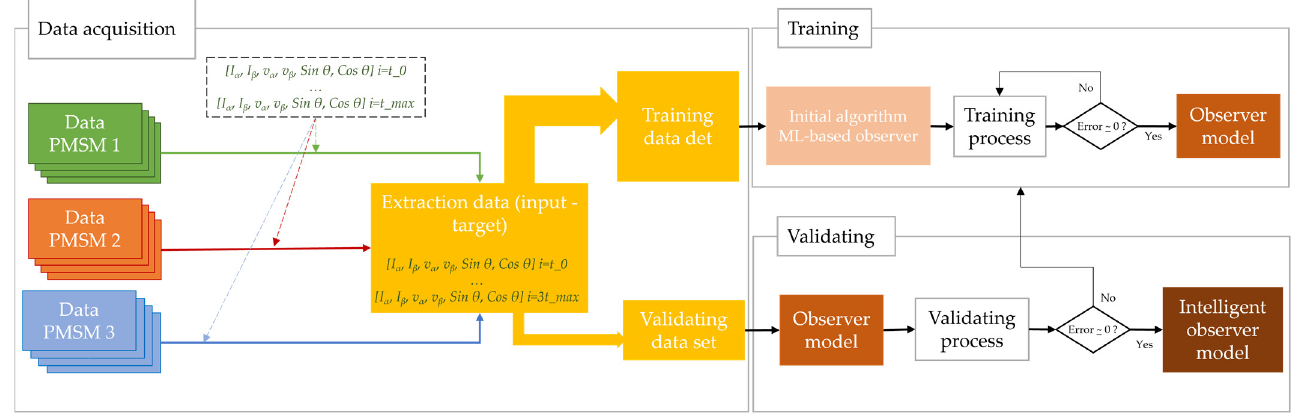
Figure 4. The development process of the intelligent observer model.